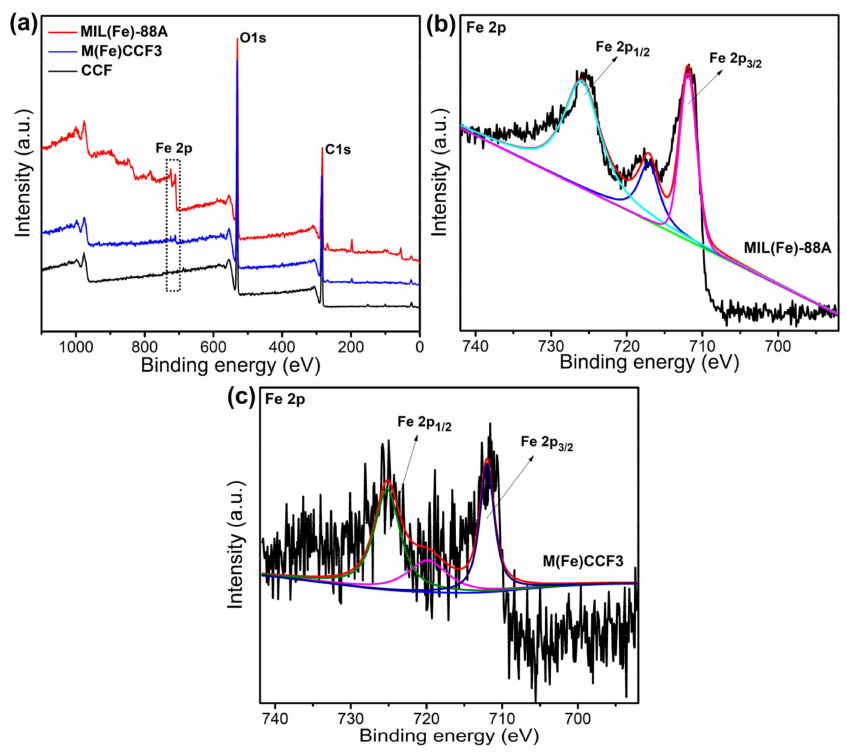
Figure 4. ( a ) The full wide-scan XPS spectra of CCF, MIL(Fe)-88A and M(Fe)CCF3; ( b , c ) The high- resolution Fe 2p spectra of the MIL(Fe)-88A and